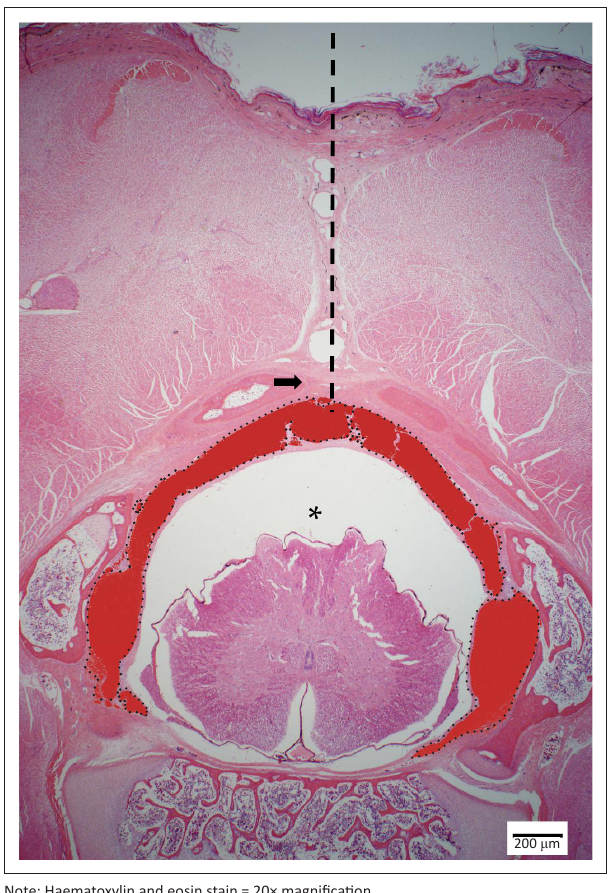
FIGURE 4: Histological transection of the post-occipital region of a